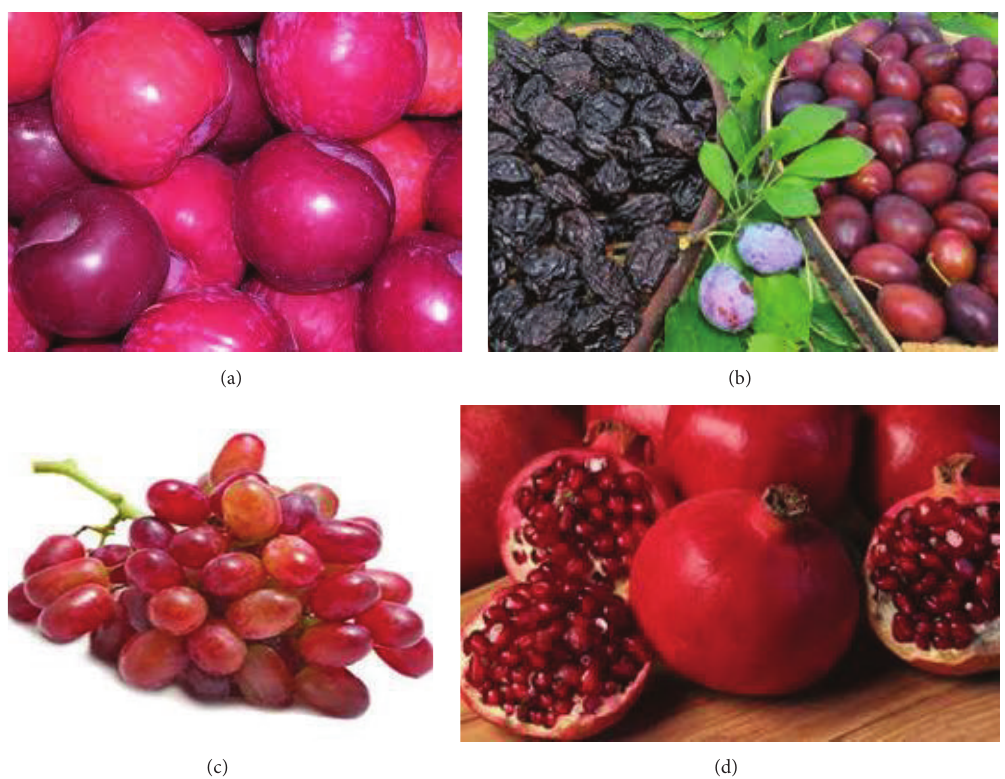
Figure 4: Structure of nutraceutical fruits for brain health: (a) plumes, (b) prunes, (c) red grapes, and (d) pomegranate.